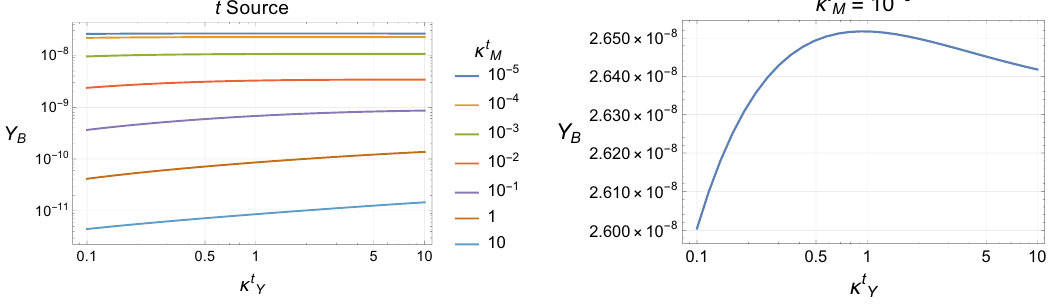
Figure 3. Left : Y B as a function of κ t for a top source. Each curve is for a particular value of Y the relaxation rate, specified by κ t . Right : a zoomed-in version on the curve κ t M corresponds to Γ t ≈ 0 . 01GeV ≈ 1 Γ b M M 5